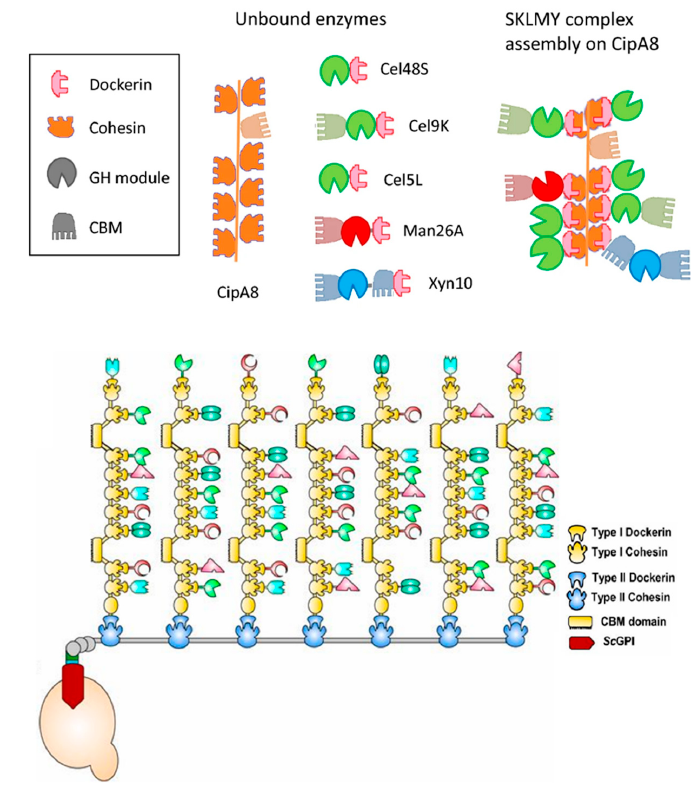
Figure 7. Synthetic cellulosomes can serve as scaffolds for optimizing cascade enzymatic reactions. ( A ) A synthetic cellulosome, with CipA8 as a scaffold, was formed by mixing cellulases (Cel48S, Cel9K, Cel5L), mannase (Man26A), and xylanase (Xyn10) in stoichiometric ratios. Reprinted from Zverlov and co-workers [99]. Copyright 2018 Springer Nature. ( B ) A cellulosome that can host 63 enzymes was displayed on the cell surface of K. marxianus through anchoring to the protein glycosylphosphatidylinositol from S. cerevisiae ( Sc GPI). Enzymes are depicted as the various green, cyan, and red shapes. Reprinted from Li and co-workers [53]. Copyright 2020 National Academy of Sciences (USA).